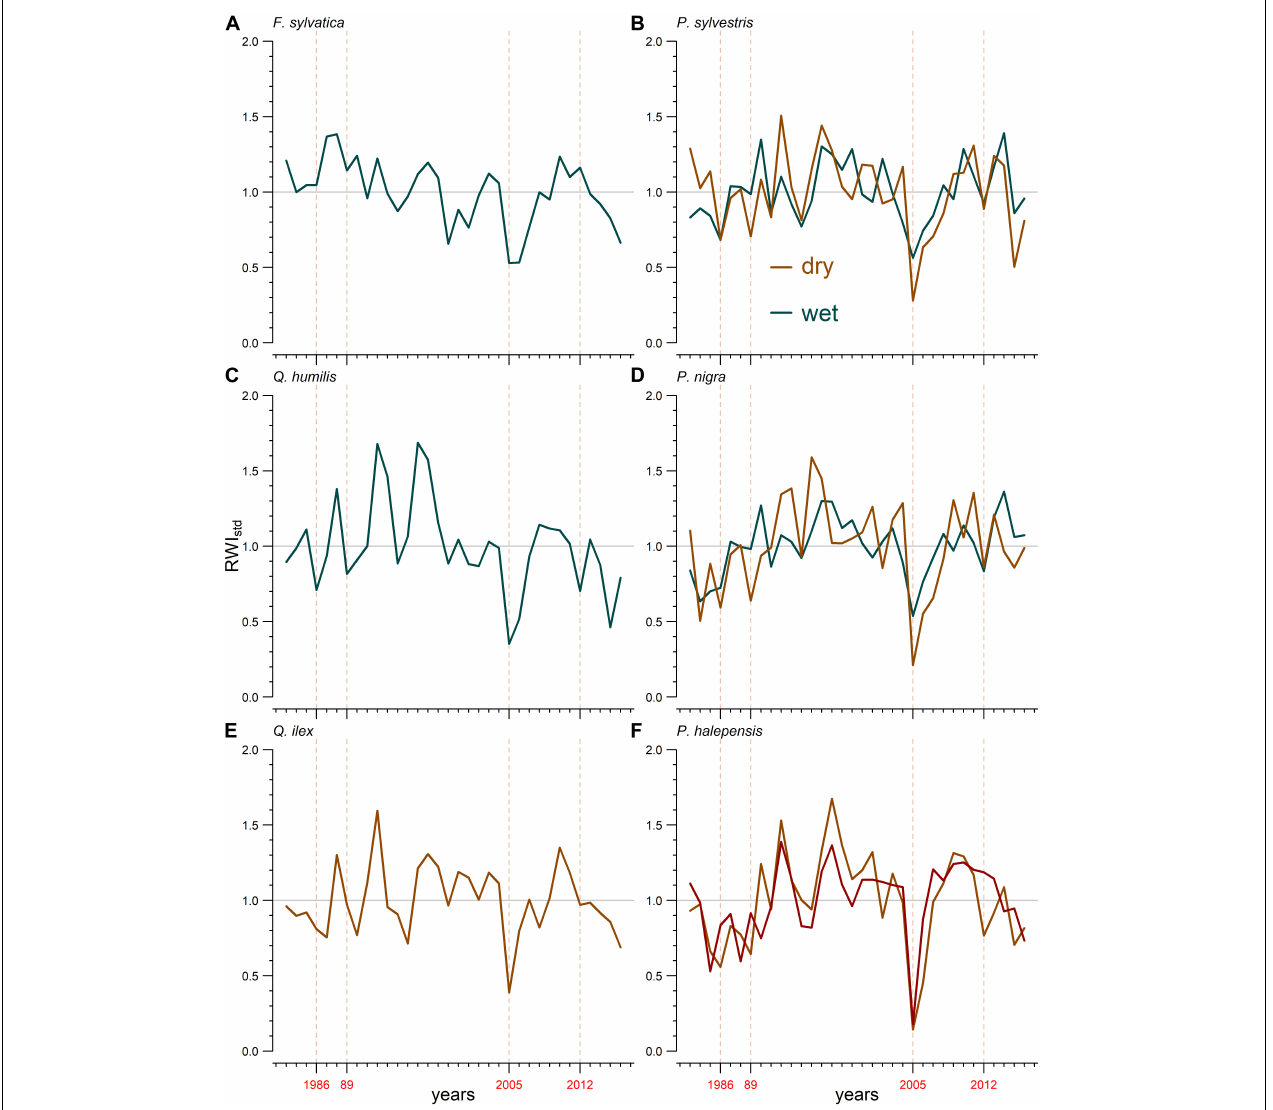
FIGURE 1 | Standardized tree-ring width chronologies (RWIstd) for the six studied species [ (A) , F. sylvatica; (B) , P. sylvestris; (C) , Q. humilis; (D) , P. nigra; (E) , Q. ilex; (F) , P. halepensis]. The horizontal line represents the mean ring-width index. Dark green colors indicate populations sampled in wet sites and brown colors indicate populations sampled in dry sites (dark red color indicates the Pinus halepensis plantation). The vertical dashed lines and numbers in red indicate major